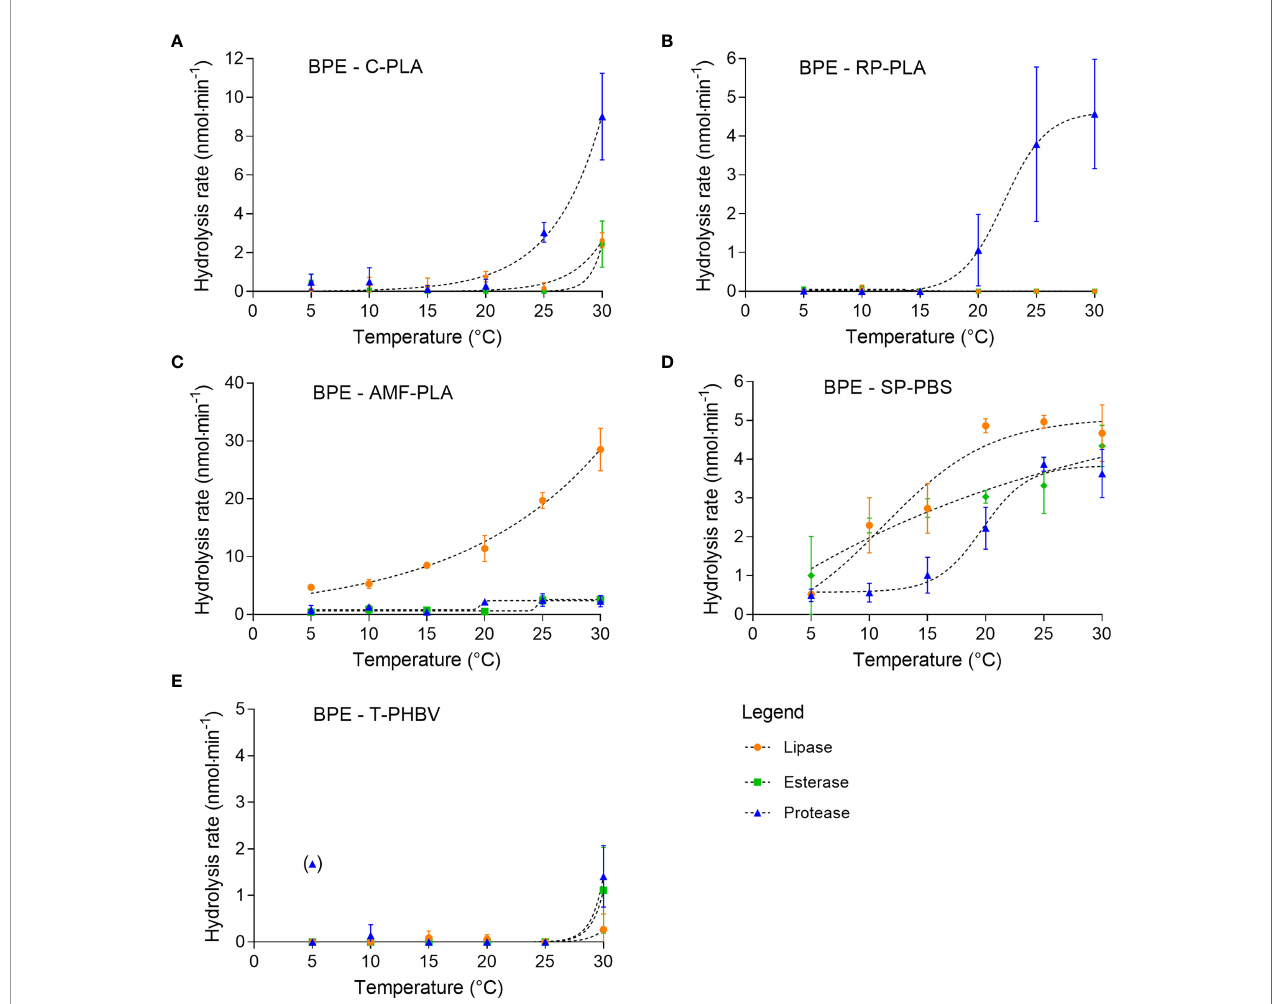
FIGURE 2 | Hydrolytic degradation of the fi ve BPE materials by lipase, esterase, and protease (A – E) measured by pH-stat degradation at temperatures between 5°C and 30°C (means ± SD, n =